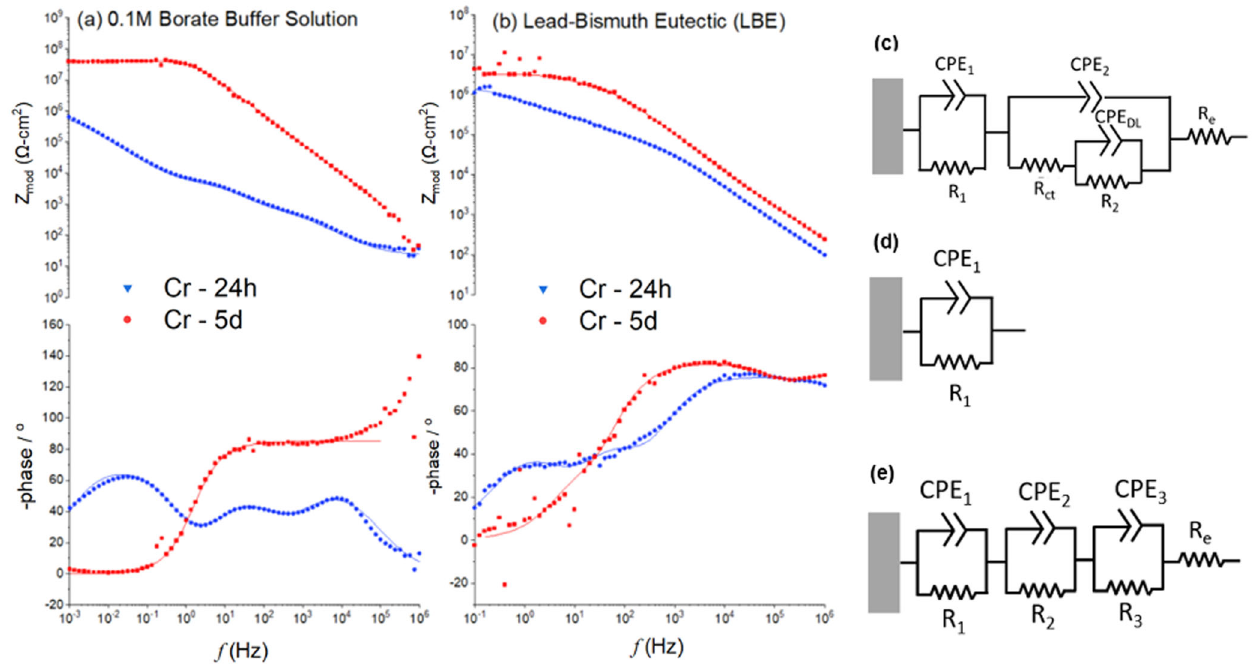
Fig. 9 Bode plots of 24 h and 5 day air oxidized chromium. Tests were conducted in a 0.1 M borate buffer at room temperature and b lead bismuth eutectic (LBE) media at 200 °C. c – e shows the representative equivalent electronic circuit (EEC) utilized to fi t the impedance data shown in a and b the fi ts are given by the solid lines; c represents a dual layer oxide model consisting of an inner porous oxide; d represents a simpli fi ed Randles circuit consisting of a time constant; e represents a model with three time